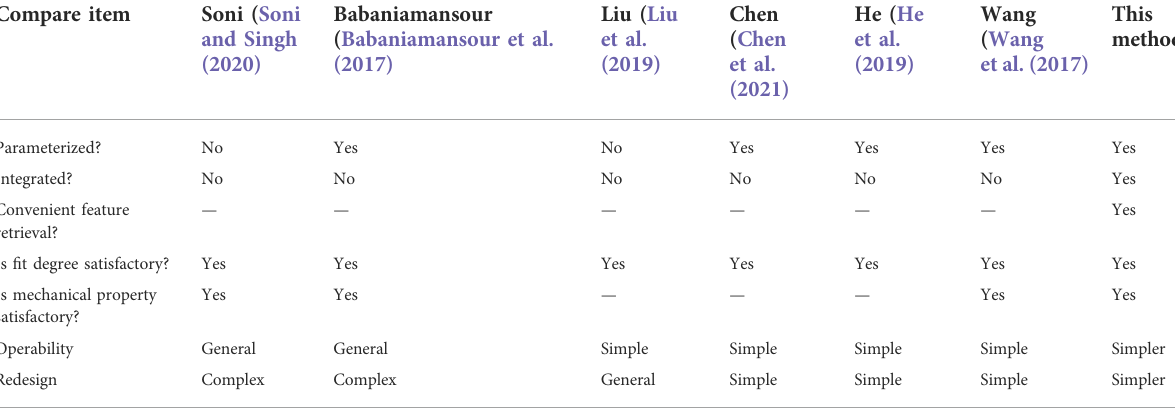
TABLE 3 Comparison between the proposed method and existing